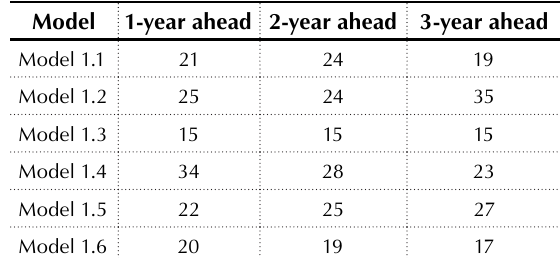
As can be seen, there is an increase in the model’s accuracy level as the time of prediction progresses.